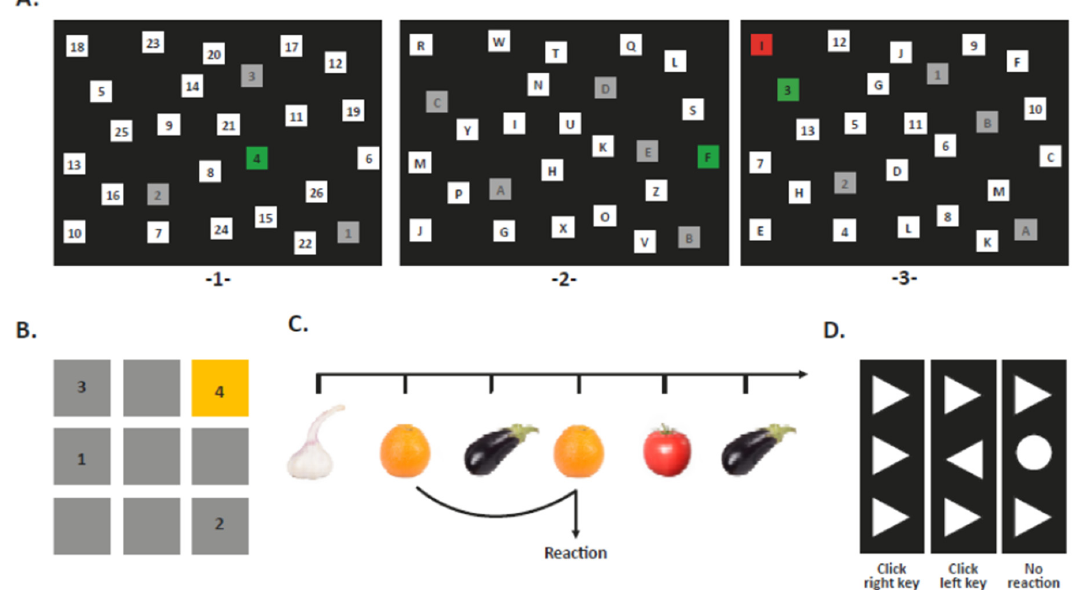
Figure 2. Computerized cognitive task. ( A ) Visual attention and task switching measured by switch task. The task comprised of three sections. 1. First section, numbers (non-switch). Numbers had to be click in ascending order with the mouse curser. 2. Second section, letters (non-switch). Letters from A to Z had to be clicked alphabetically. 3. Third section, number and letters (switch). Numbers and letters had to be clicked alternately in ascending order (i.e., 1-A-2-B-3-C ... ). ( B ) Visual-spatial attention and working memory measured by corsi-block tapping task. Forward sequence of blocks was displayed and gradually increased in length up to six blocks. The sequence in the order had to be repeated. ( C) Working memory updating measured by 2-back task. Fruits and vegetables were displayed on a computer screen. A predefined key had to be pressed when the current image was the same as the image two trials back. (D ) Inhibitory control measured by flanker task. Directional